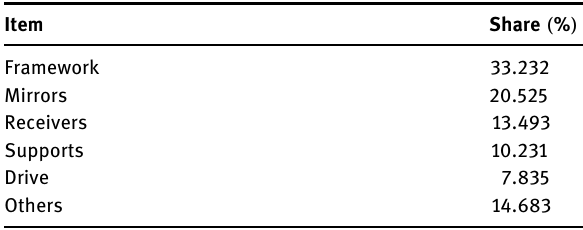
Table 13: Breakdown of material